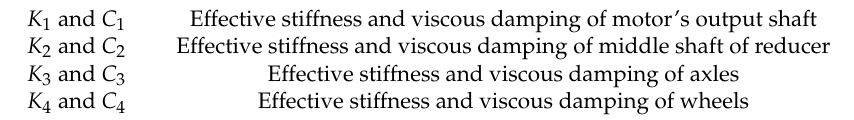
Table 3. Torsional stiffness and viscous damping in the driveline